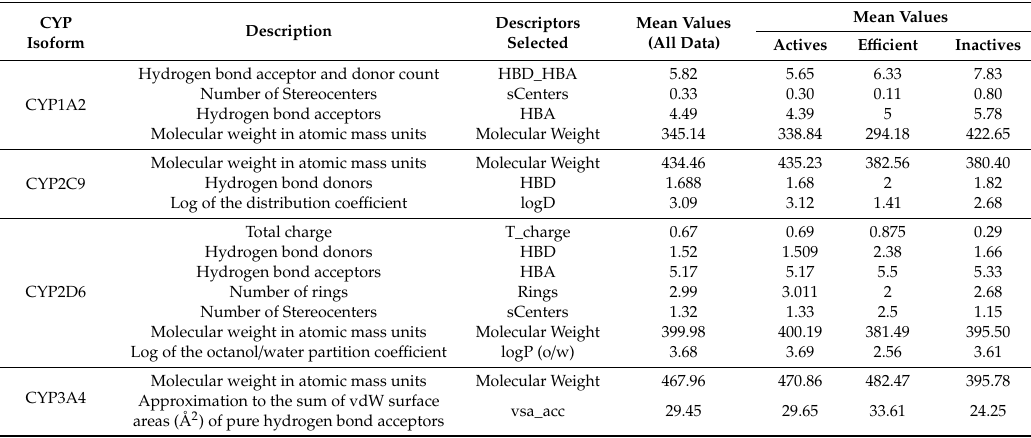
Table 3. The relevant set of descriptors for each CYP inhibition decision tree classifier along with the description, average values of selected descriptors for active, e ffi cient and inactive inhibitors against each CYP isoform are presented.